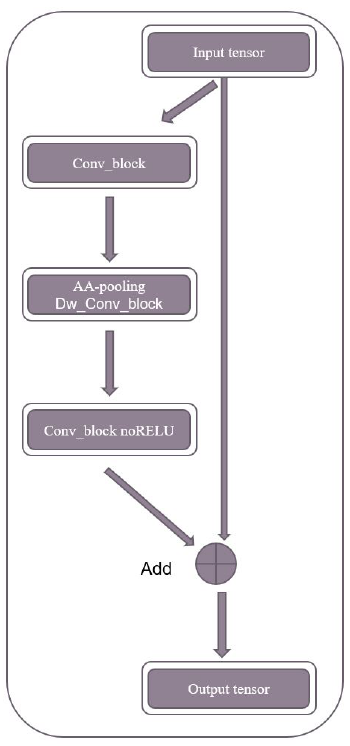
Figure 4. The bottleneck